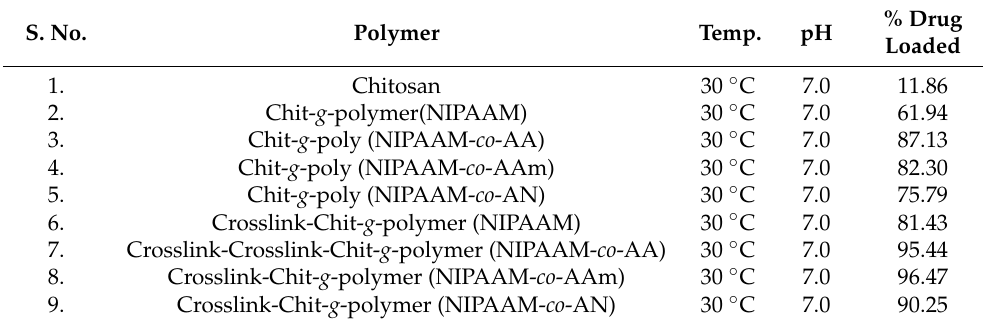
Table 2. Drug Uptake by Chitosan, graft copolymers and Crosslinked Graft Copolymers a of NIPAAM and Binary Comonomers onto